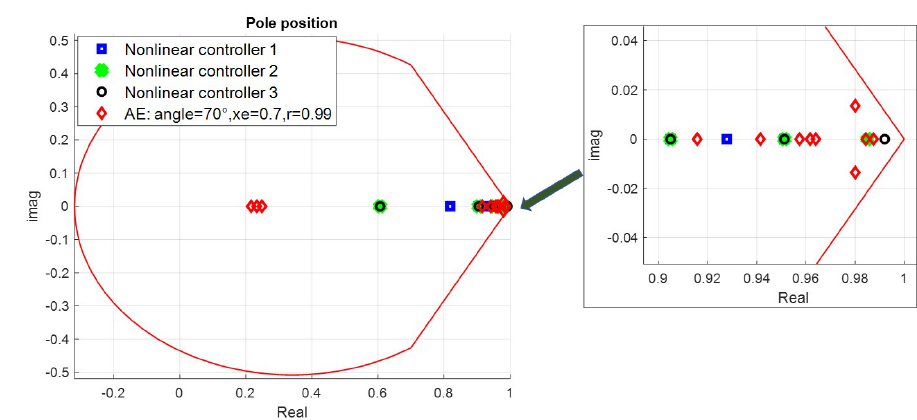
Figure 21. Closed loop discrete poles position recalculated with sampling period T s = 0.001 s for nonlinear controllers and for the best of robust controllers designed for AE